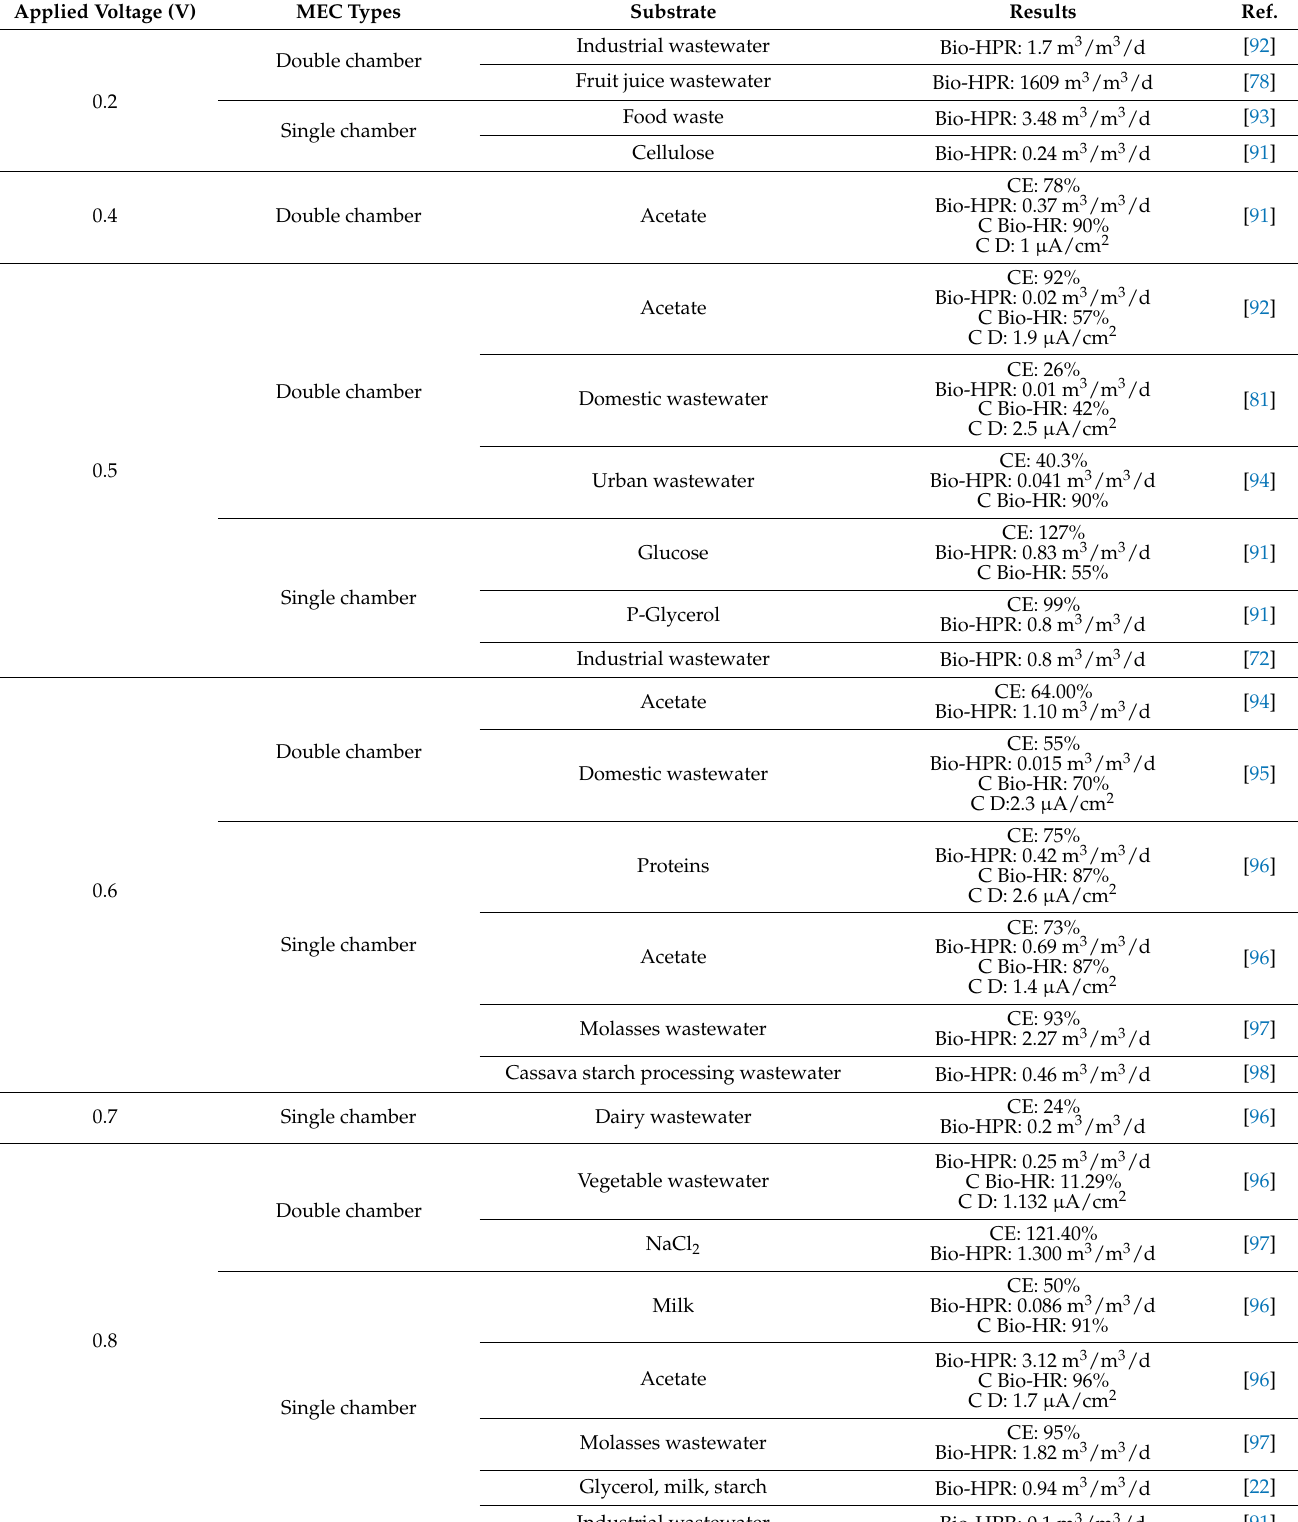
Table 6. Effect of applied voltage (V) on performance of